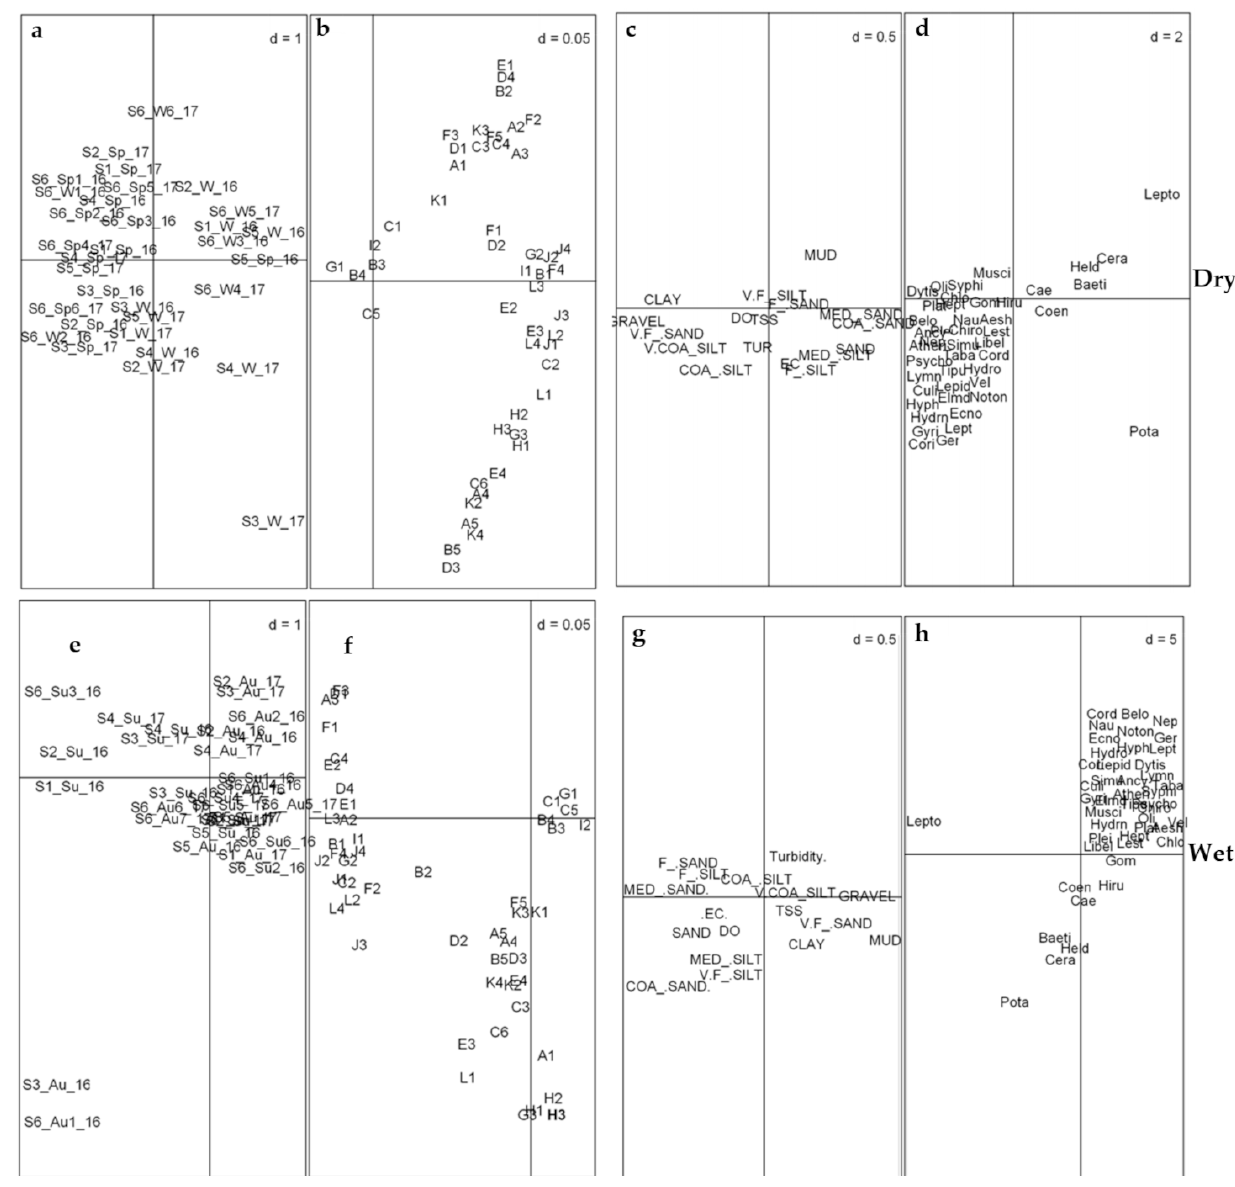
Figure 2. RLQ plot showing the site clustering ( a , e ) during the sampling seasons based on environmental variables ( c , g ), trait ( b , f ) and macroinvertebrates ( d , h ) during the dry and wet seasons over the study period (August 2016–March 2018) in the Tsitsa River and its tributaries. Abbreviations: traits are as in Table 1, for traits and ecological preferences, physico-chemical variables and suspended grain sizes in Table 2; taxa: Oli: Oligonuridae, Baeti: Baetidae, Coen: Coenogranidae, Gom: Gomphidae, Lepto: Leptophlabidae, Held: Helodidae, Dyti: Dytiscidae, Pota: Potamonautidae, Cera: